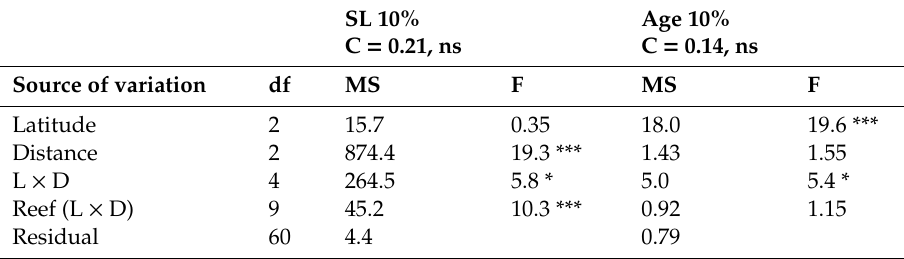
Table 3. Results of Analysis 1, a partially hierarchical ANOVA, testing for di ff erences among three distances across the shelf and three latitudes; fish were sampled at two reefs for each combination of the main factors ( n = 4 fish per reef); dependent variable was standard length top 10% (SLMAX 10%) or age top 10% (AMAX 10%). Distance and latitude were tested as fixed factors and site as random. C = Cochran’s test for homogeneity of the data, k = 18, df = 3, * p < 0.05; *** p < 0.001; ns = not significant.